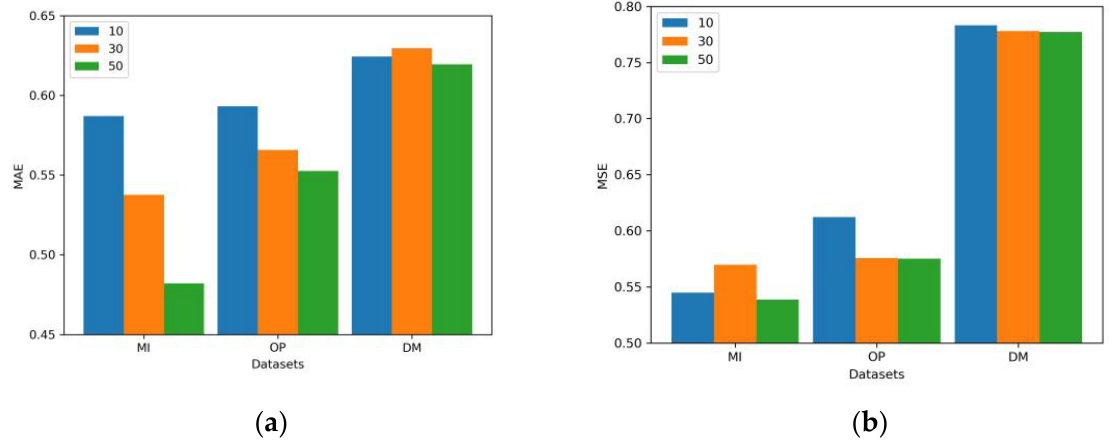
Figure 6. Performance of the different embedding size of the RSII model. ( a ) The MAE of different embedding size; ( b ) The MSE of different embedding size.